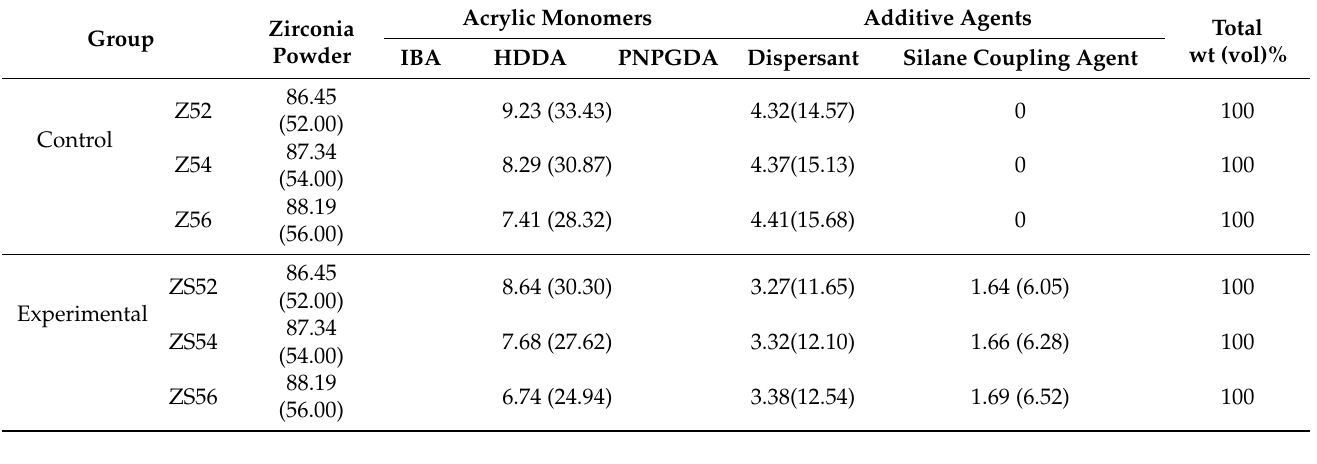
Table 1. Experimental groups in this study.